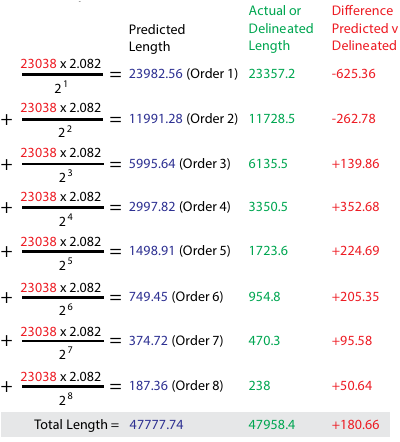
Figure 5, Initial Formula Deducted from SEQ Data Multiplied Fractal Dimension of 2 Given a difference of over 2062 km in the predicted v the actual mapped results, refinement of the model was required. This was completed by replacing the fractal of 2 with a number derived from total length of mapped waterways divided by the total area (2.082) (As displayed in Figure 6).